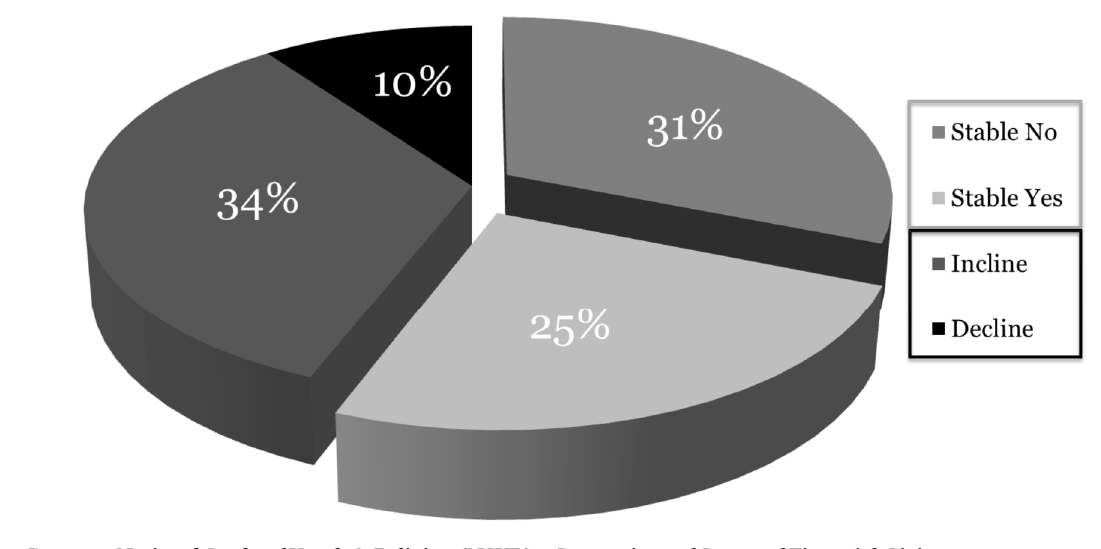
Figure 2. Changes Over Time in Emerging Adult Financial Giving to Charitable Causes.